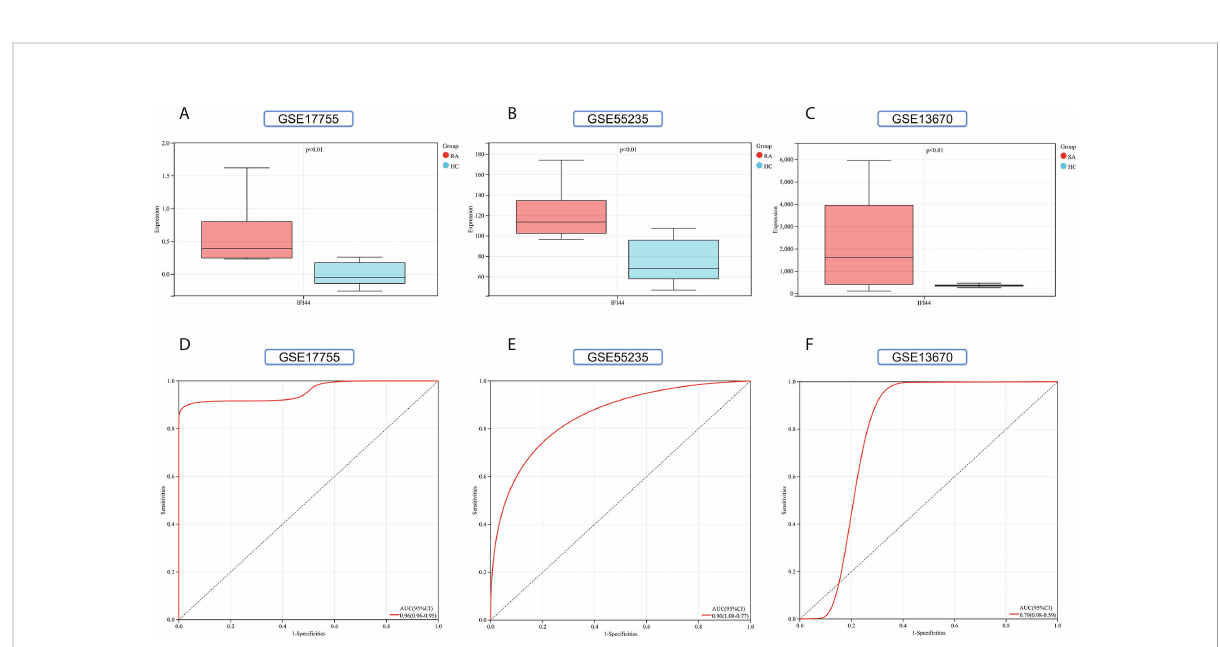
FIGURE 12 Validation of key genes. (A – C) The expression of IFI44 in GSE17755, GSE55235, and GSE13670. Red for RA/ S. aureus group, and cyan for HC group. (D – F) The AUC of the ROC curve veri fi es the diagnostic validity of IFI44 in GSE17755, GSE55235, and GSE13670 ( P <